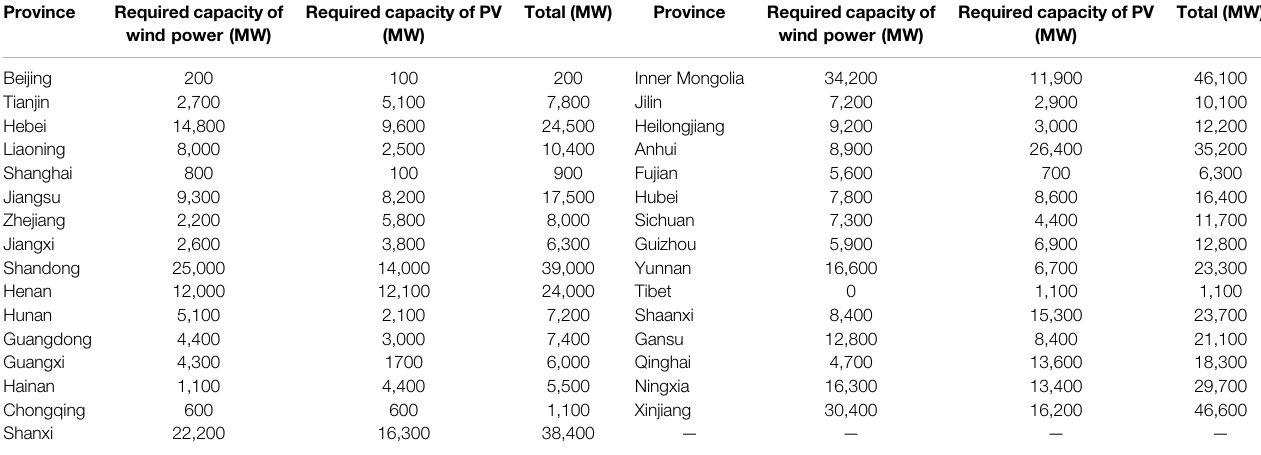
TABLE 2 | Required capacity of renewable energy power